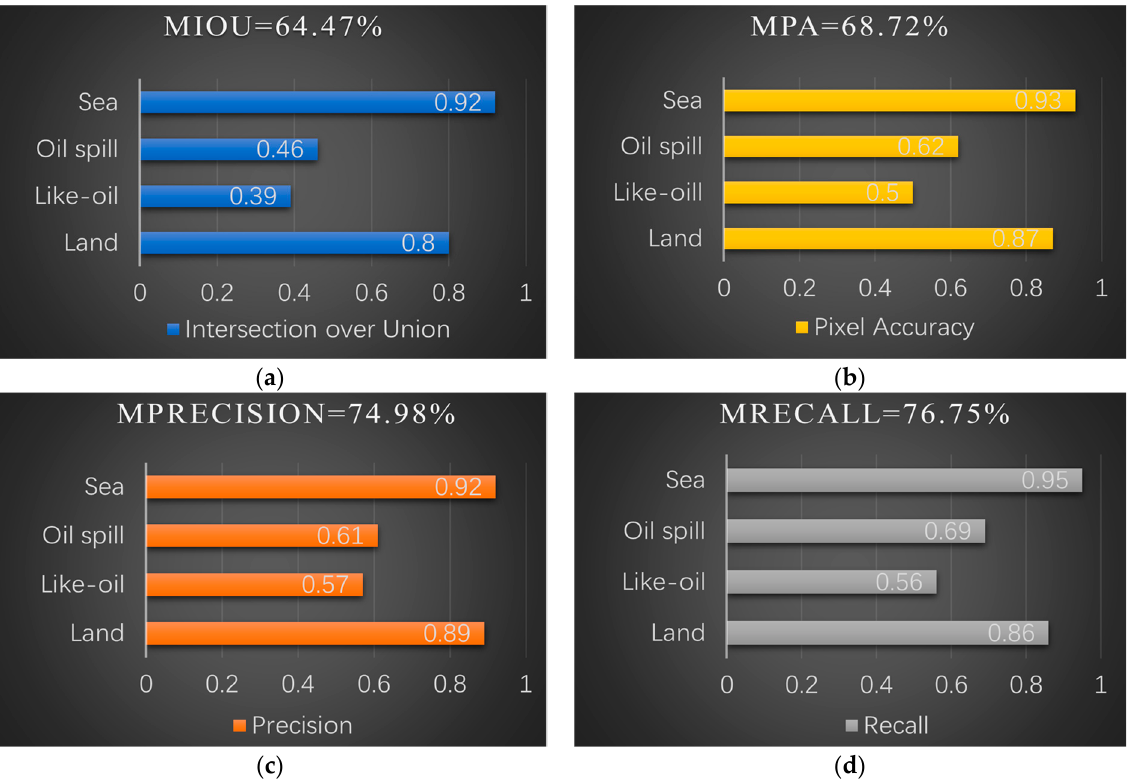
Figure 7. Testing results obtained on ASA-DRNet. ( a ) mIOU; ( b ) mPA; ( c ) mPrecision; ( d ) mRecall.